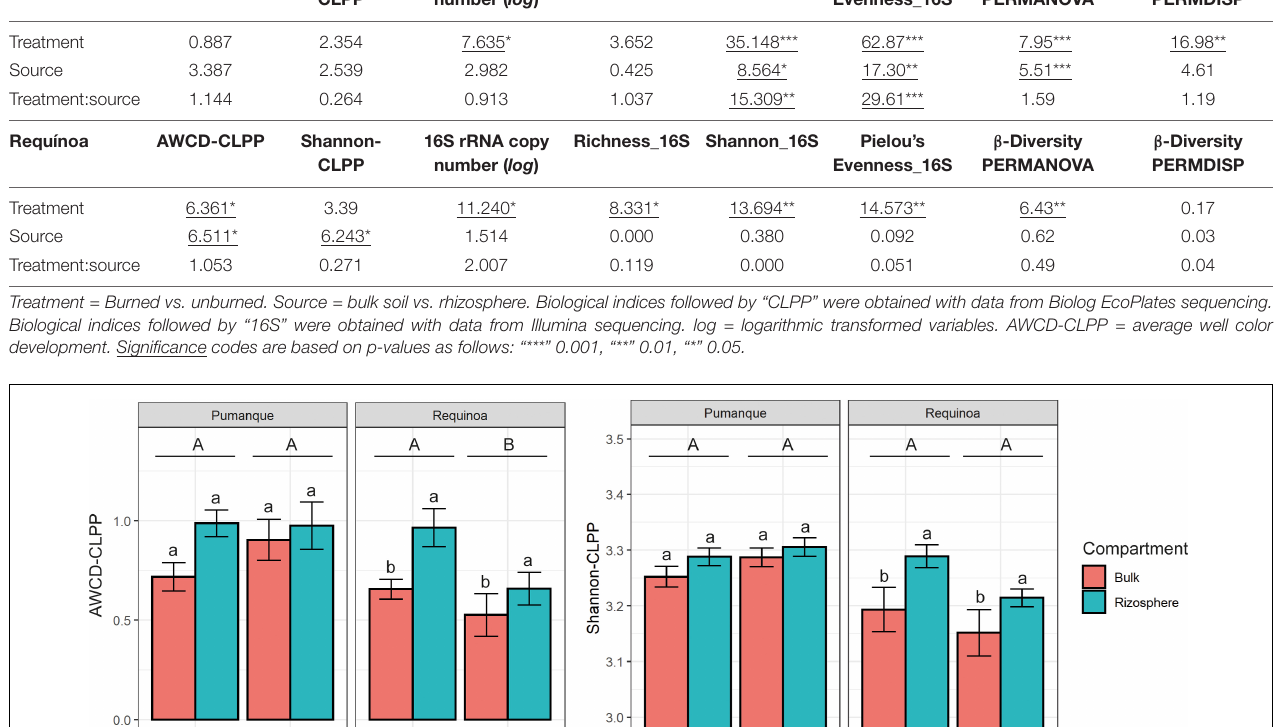
TABLE 1 | F -values from two-way ANOVA for biological activity and α -diversity of prokaryotic communities, permutational multivariate analysis (PERMANOVA), and permutation test for homogeneity of multivariate dispersion (PERMDISP) for prokaryotic community ( β -diversity) (the table is split by study locations). Pumanque AWCD-CLPP Shannon- 16S rRNA copy CLPP number ( log